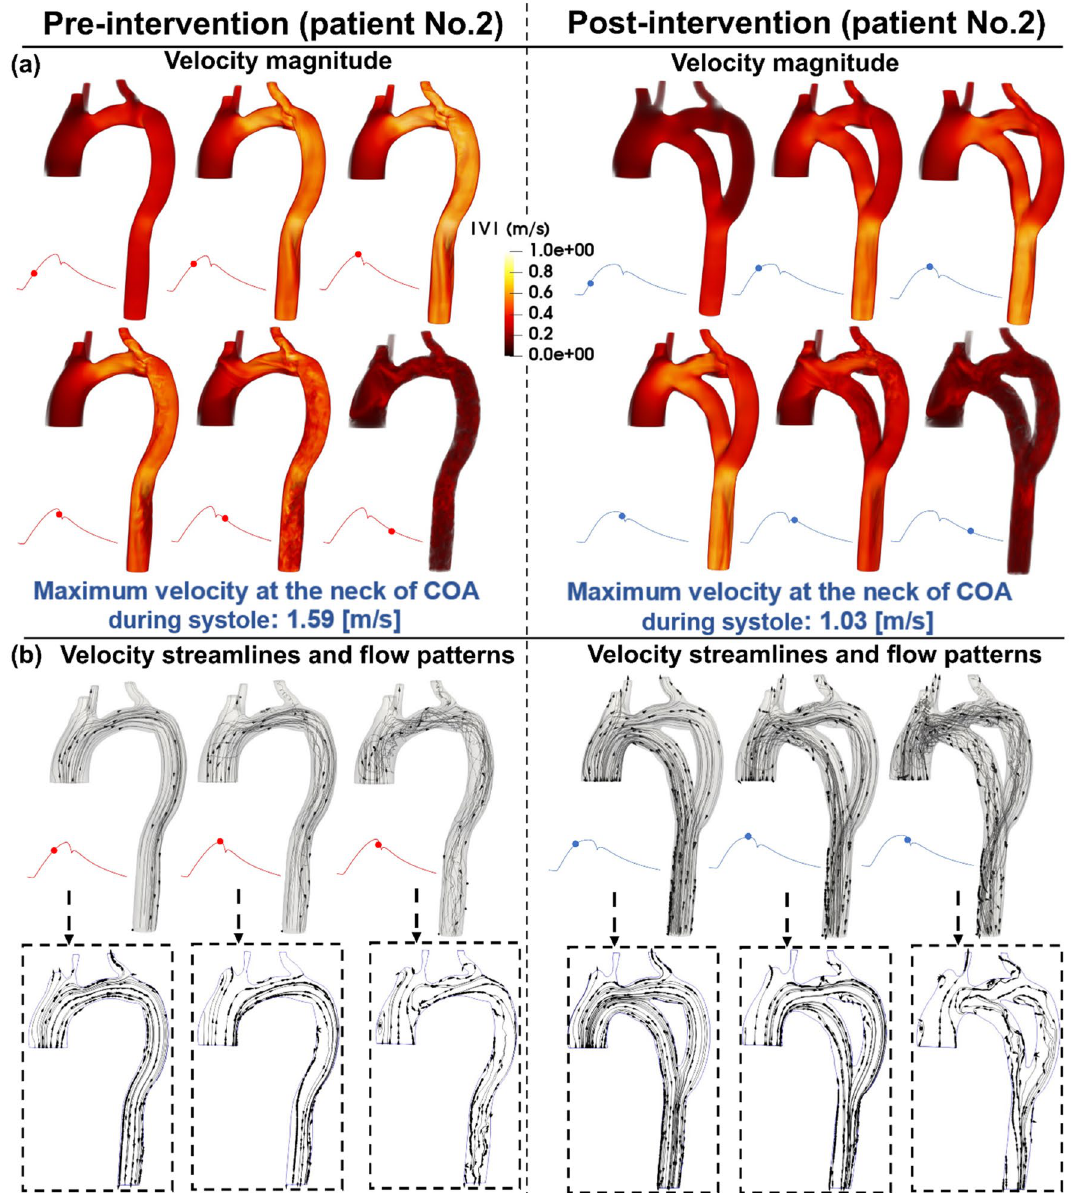
Figure 5. Flow modeling in Patient No. 2 in pre and post intervention status. ( a ) Time-evolving velocity magnitude at six instances; ( b ) 3-D (upper row) and 2-D (lower row) streamlines through the aorta at three instances. Baseline characteristics (Patient No. 2): COA and